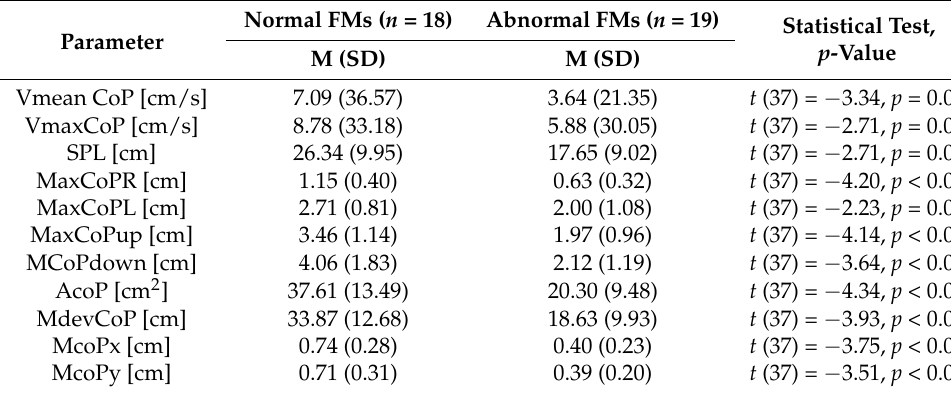
Table 3. Differences in CoP parameters describing the spontaneous sway of CoP and the area of CoP between the groups of infants who presented with normal and abnormal FMs in PT in the supine position.